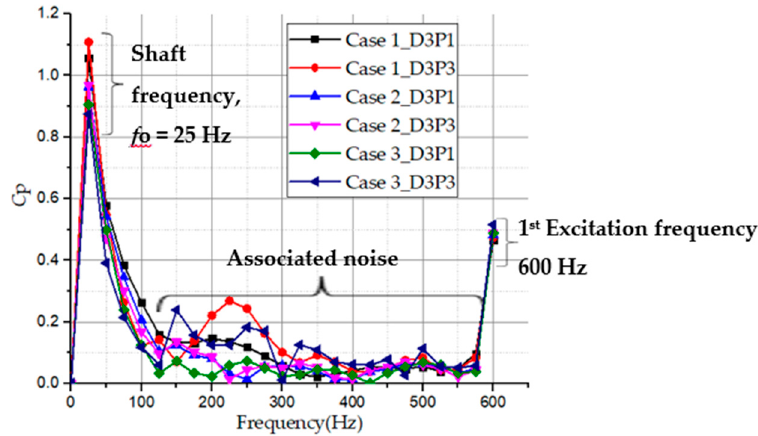
Figure 19. Detailed frequency domain history of pressure fluctuation in impeller passage for all pump cases below 600 Hz. cases below 600